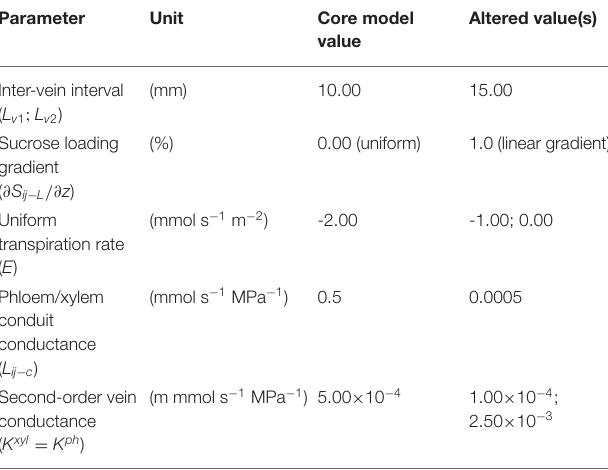
TABLE 4 | Summary of system parameters with core and additional values. Parameter Unit Core model